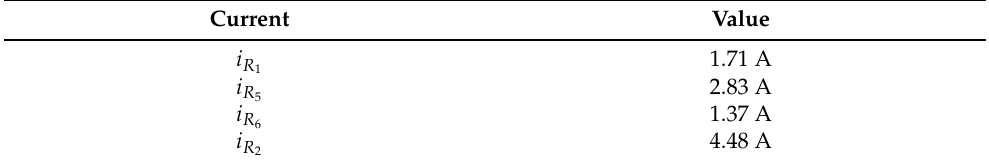
Table 3. Branch currents from Figure